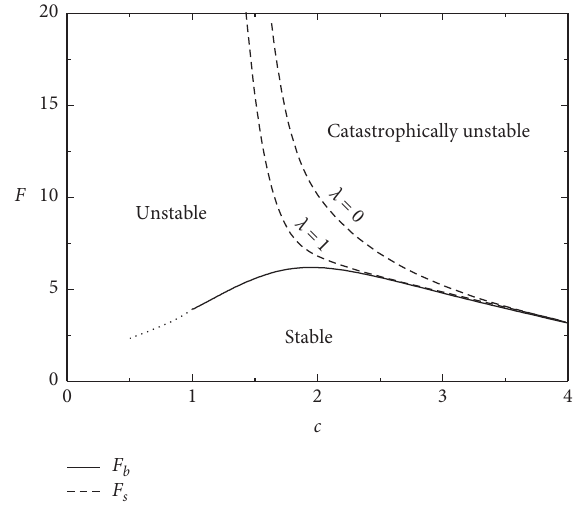
Figure 4: FEM result of F b and F s against the span length of the frame c for a symmetric portal